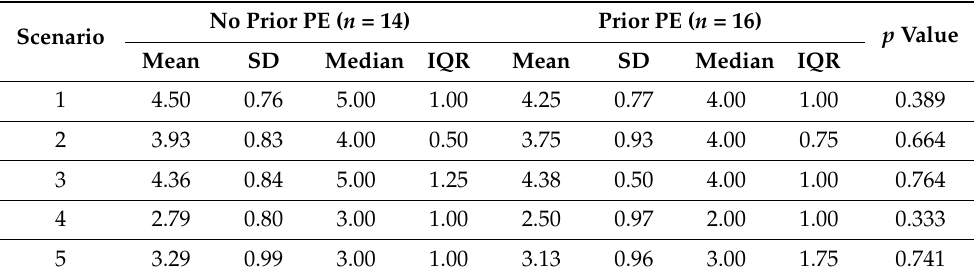
Table 2. The mean, standard deviation (SD), median, and inter-quartile range (IQR) of the ordinal scores for each scenario from patients with and without prior